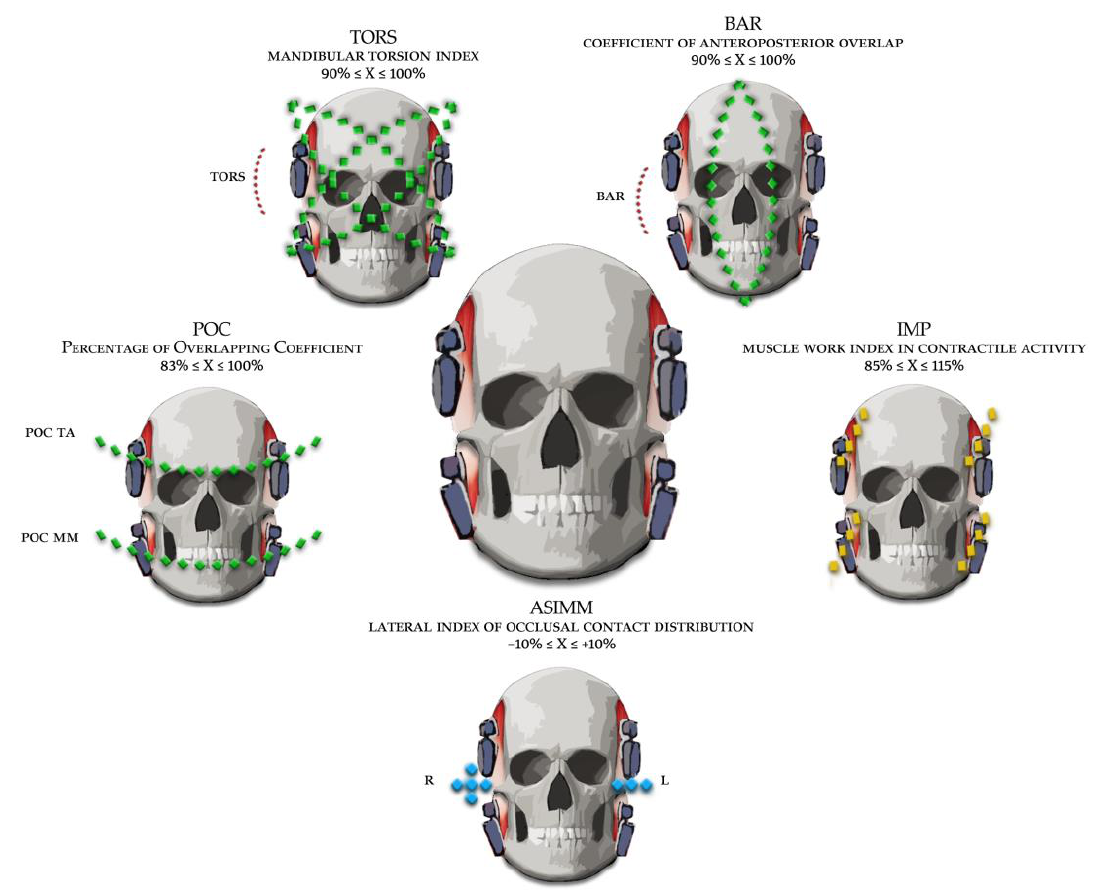
Figure 1. Functional sEMG Indices. Blue lines: representation of the polarity of asymmetry. Green lines: overlap plans. Yellow lines: representation of muscle activity. POC TA and MM: Percentage overlapping coefficient (anterior temporalis muscles or masseter muscles), measuring of the predomi- nance of the right or left anterior temporalis in the anterior teeth contacts and masseter muscle in the posterior occlusal contact. BAR: Barycenter as percentage overlapping coefficient between posterior and anterior teeth contact. A measure of the predominance of the posterior or anterior teeth contacts. TORS: Torsion index is obtained by comparing the torque of the crossed muscle pairs. IMP: Impact index as the work performed by the muscle during its contractile activity. The work is represented geometrically by the area subtended to the curve of electrical activity of the muscles examined over time. ASIM: Asymmetry index. The distribution of the occlusal contacts considering the right and left parts of dental arches, on the frontal plane. The pairs of muscles examined are represented by the temporalis and masseter muscles.